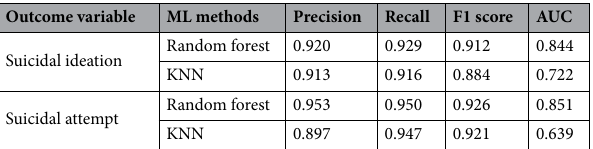
Table 3. Evaluation metrics. Area under curve (AUC) is calculated for every class against all other classes.